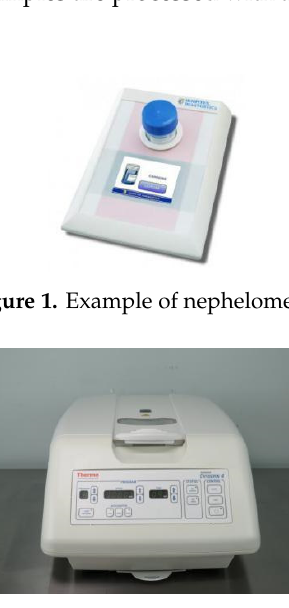
Figure 3. Example of cytofunnel.